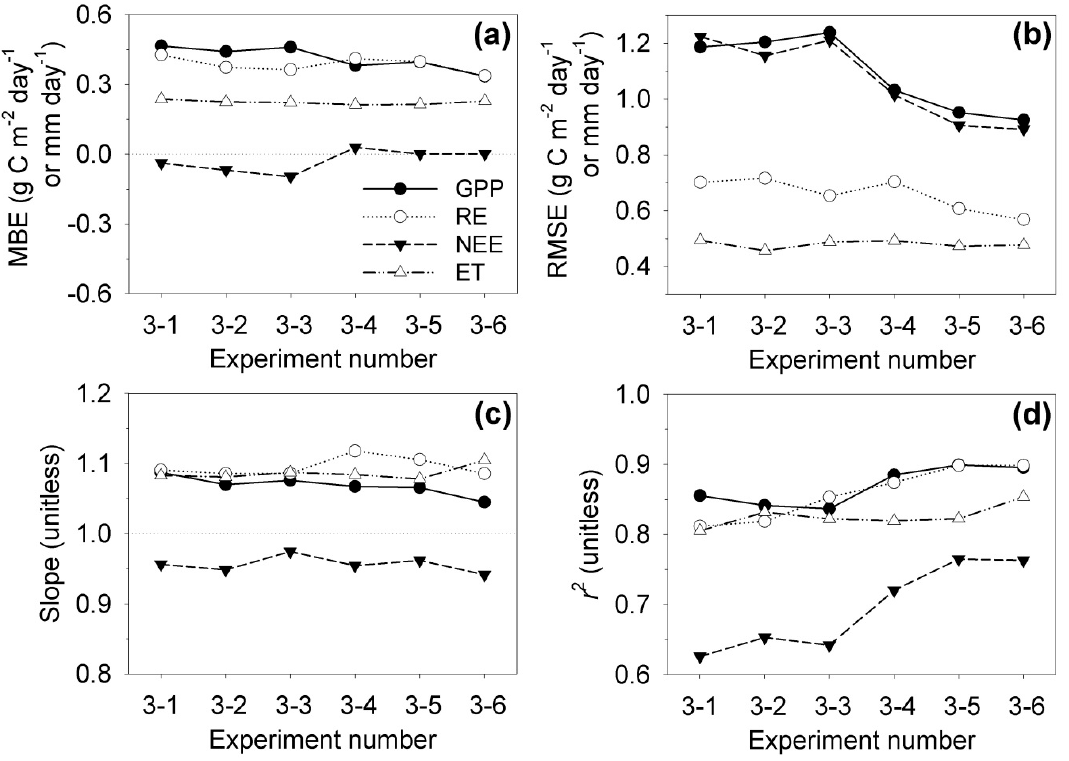
Figure 6. Same as Figure 4, but for Experiments 3-1, 3-2, 3-3, 3-4, 3-5, and 3-6. MBE ( a ) and RMSE ( b ) indicate mean bias error and root-mean-square error, respectively. Slope ( c ) and r 2 ( d ) obtained from linear regression analysis.